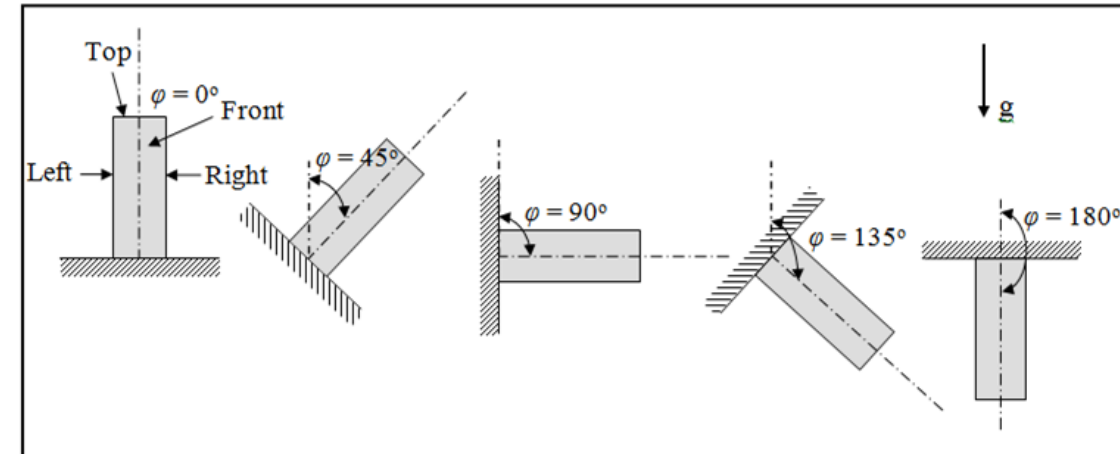
Figure 2. Illustration of the positions and surfaces of the slender cuboid.